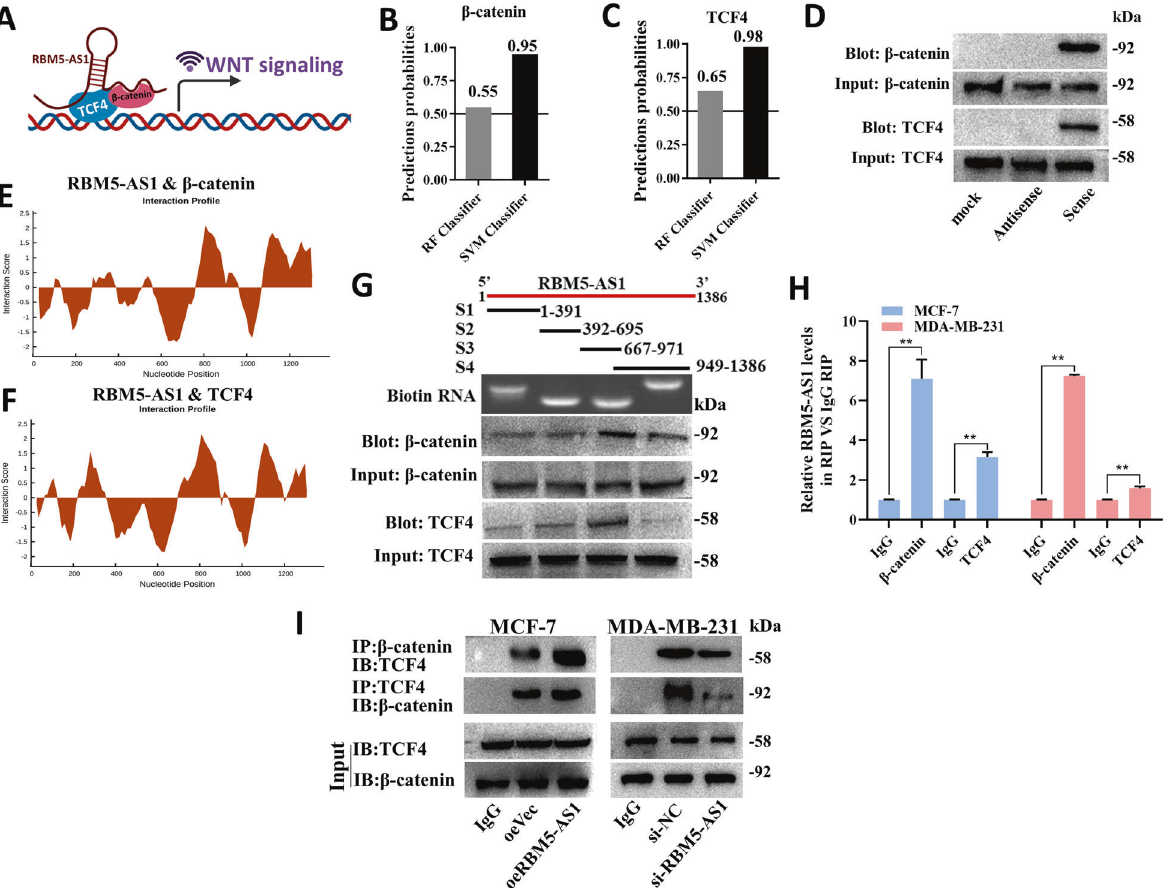
Fig. 7 RBM5-AS1 facilitates β -catenin function through organizing β -catenin-TCF4 transcription complex. A Schematic diagram of the hypothesis that RBM5-AS1 promotes β -catenin/TCF4 interaction via binding with them to activate Wnt/ β -catenin signaling. The possibility of interaction between RBM5-AS1 and β -catenin ( B )/TCF4 ( C ) was predicted by RPISeq predictions. D Proteins pulled down by biotin-tagged RBM5-AS1 sense or antisense were detected using β -catenin/TCF4 antibody. The interaction between β -catenin ( E )/TCF4 ( F ) protein and RBM5- AS1 was predicted using catRAPID. G Mapping of β -catenin/TCF4-binding domains of RBM5-AS1. Schematic of RBM5-AS1 full-length and truncated fragments (upper); agarose gel electrophoretogram of biotin-tagged RNA of truncated RBM5-AS1 (middle); western blotting of β -catenin/TCF4 in RNA-pulldown samples bound with different RBM5-AS1 fragments (lower). H The interaction between RBM5-AS1 and β -catenin/TCF4 was validated by RIP assays with β -catenin/TCF4 antibody (IgG served as a negative control). I Altered binding activity between β -catenin and TCF4 was detected in MCF-7 cells with RBM5-AS1-overexpression and MDA-MB-231 cells with RBM5-AS1-knockdown using co- IP analysis. All data are shown as the mean ± SEM. * P < 0.05 and ** P < 0.01 by two-tailed Student ’ s t